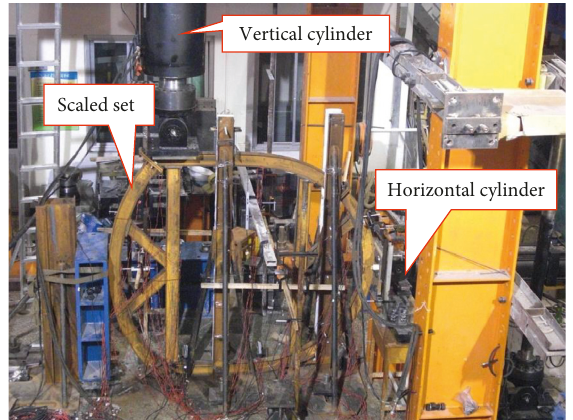
Figure 3: Loading system in the laboratory.